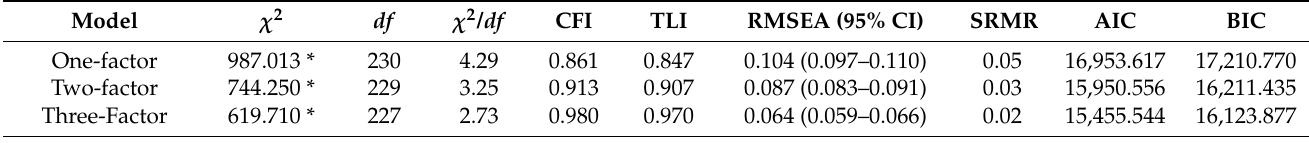
Table 2. Confirmatory Factor Analyses Results ( N = 307).